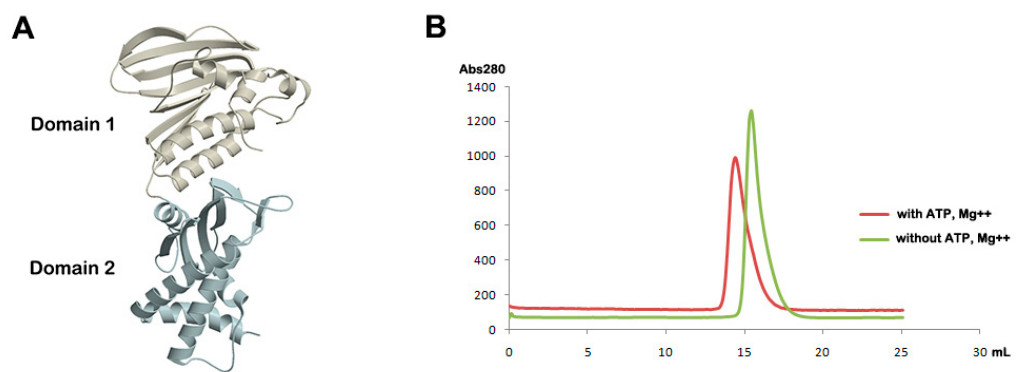
Figure 1. Overall structure of Xoo ParE. ( A ) The monomeric structure of Xoo ParE 43 kD ATPase domain. Domain 1 and domain 2 are shown by different colors. ( B ) Analytical gel-filtration chromatography of Xoo ParE in the absence and presence of ATP and magnesium ion.